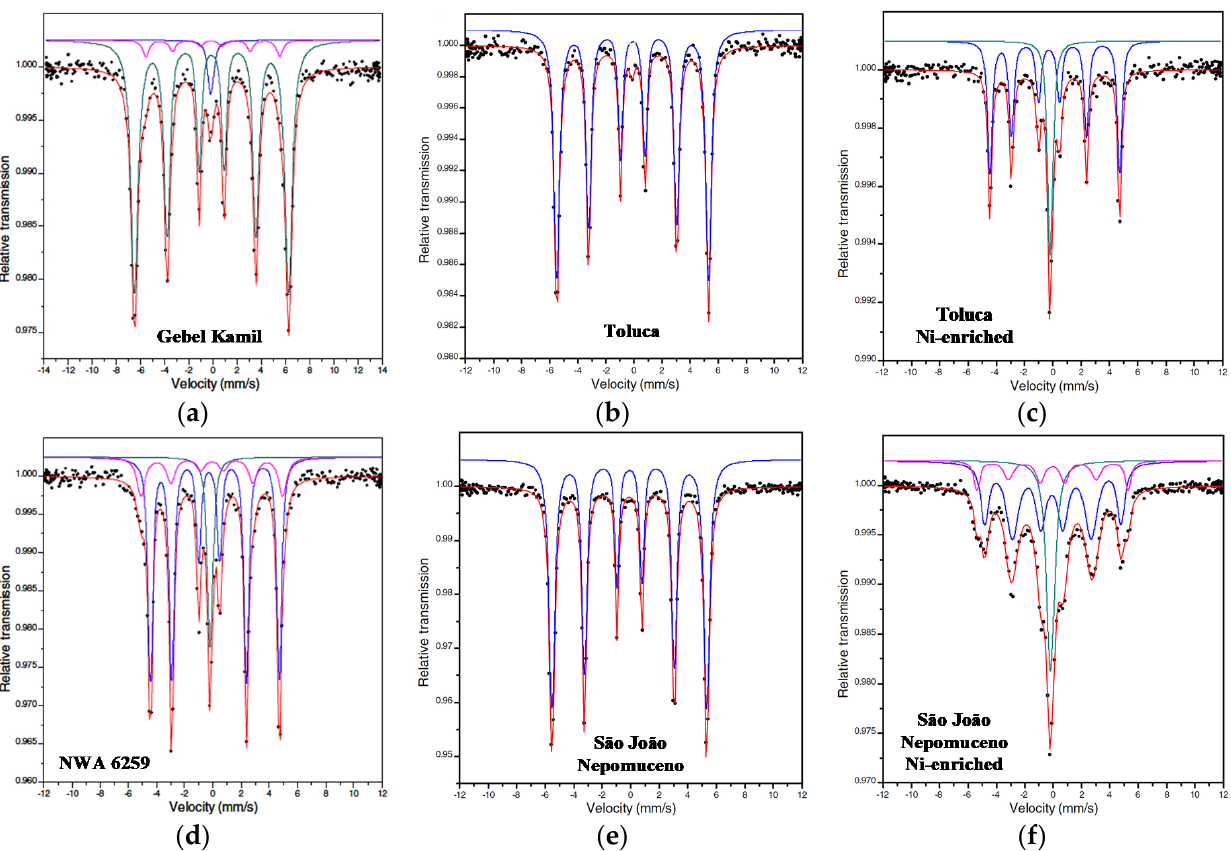
Figure 30. Room temperature Mössbauer spectra of iron meteorites: Gebel Kamil ( a ), Toluca ( b ), Toluca Ni-enriched ( c ), NWA 6259 ( d ), São João Nepomuceno ( e ), and São João Nepomuceno Ni-enriched ( f ). Indicated spectral components are the results of the fits. Adapted from [42].